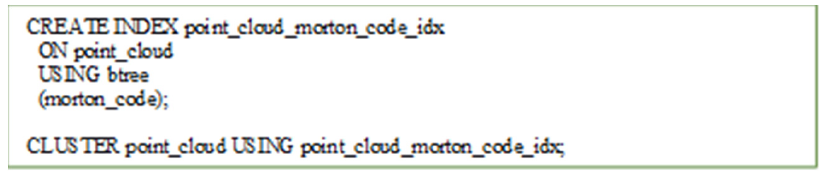
Figure 11. SQL command for indexing point cloud Morton code.